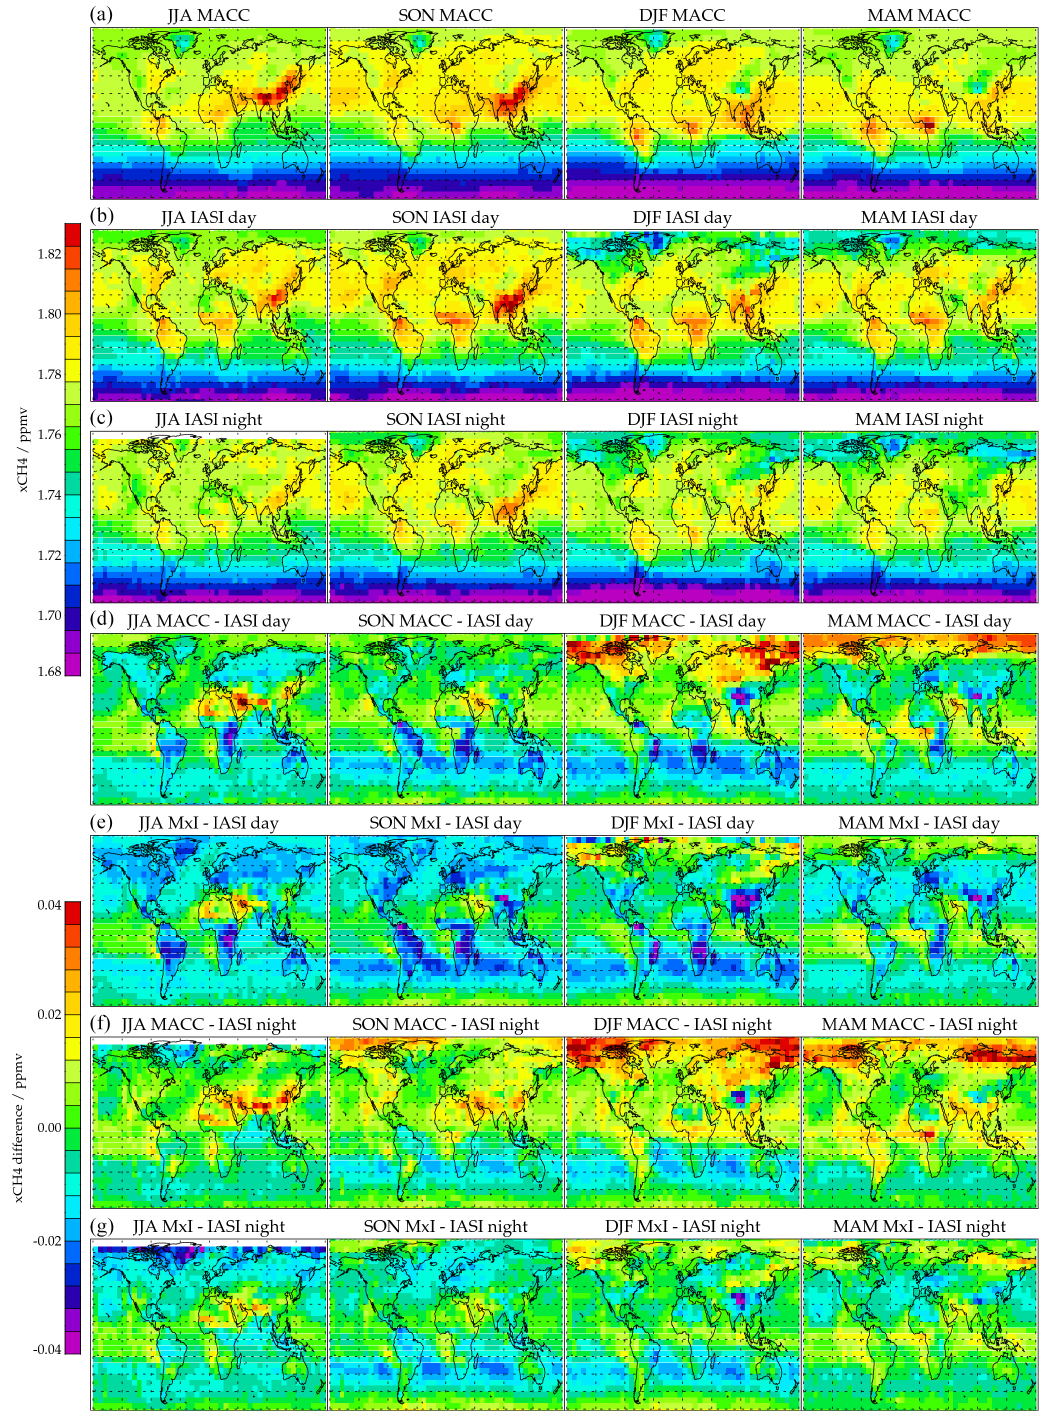
Figure 6. Comparisons of IASI and MACC-II GHG column-averaged mixing ratio. Each column of the figure shows results for a differ- ent season; JJA is June, July and August 2009; SON is September, October and November 2009; DJF is December, January and Febru- ary 2009/10; MAM is March, April and May 2010. Panels (a–c) show, respectively, results from MACC-II GHG, IASI daytime retrievals and IASI night-time retrievals. Panels (d–g) show differences between MACC-II GHG and IASI, separately for day and night, with and without applying the IASI averaging kernels. MxI is used in the panel titles as shorthand for “MACC-II GHG after applying IASI averaging